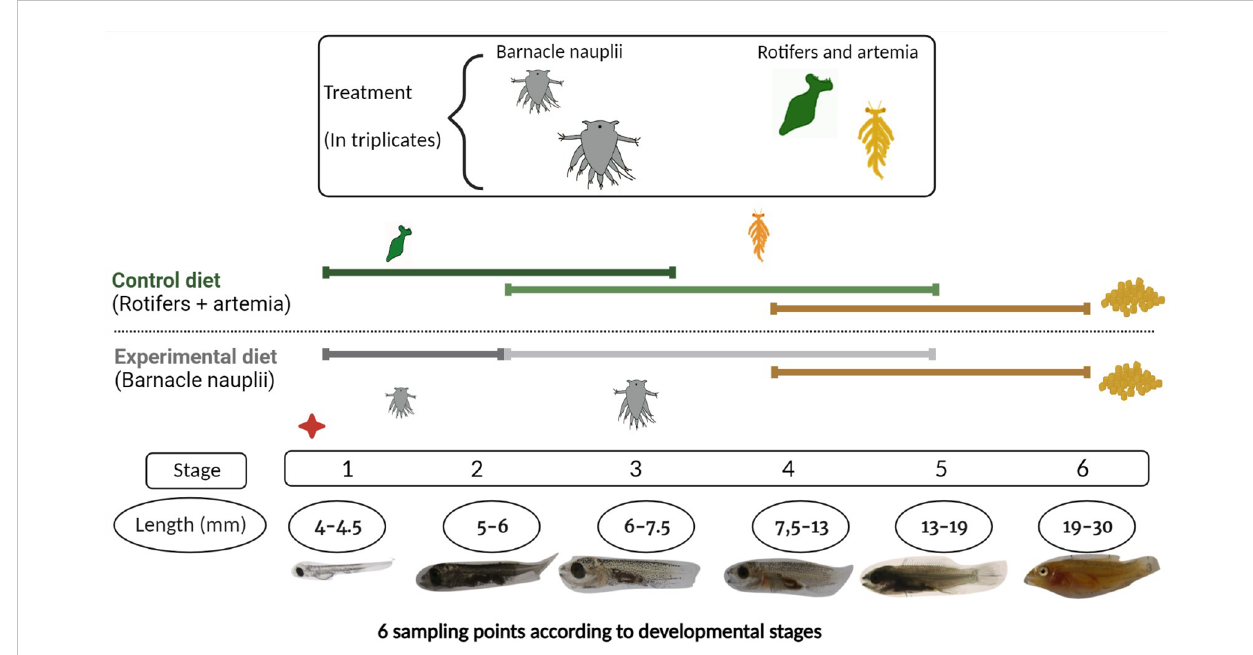
FIGURE 1 Experimental design. Two start-feed diets were given in triplicates: a control diet (rotifers and artemia), and an experimental diet, so-called barnacle diet (barnacle nauplii). The control and barnacle diet are represented in green and grey color respectively and colors are used henceforth for easier interpretation of results. Six sampling points were done according to developmental stages of wrasse larvae. After stage 6 they were considered juveniles. The red dot indicates the start of the feeding trial at 4 dph with rotifers and small barnacle correspondingly. Artemia and large barnacles were introduced at stage 2 and commercial feed (pellets) were introduced in a co-feeding regime at stage 4. Created with